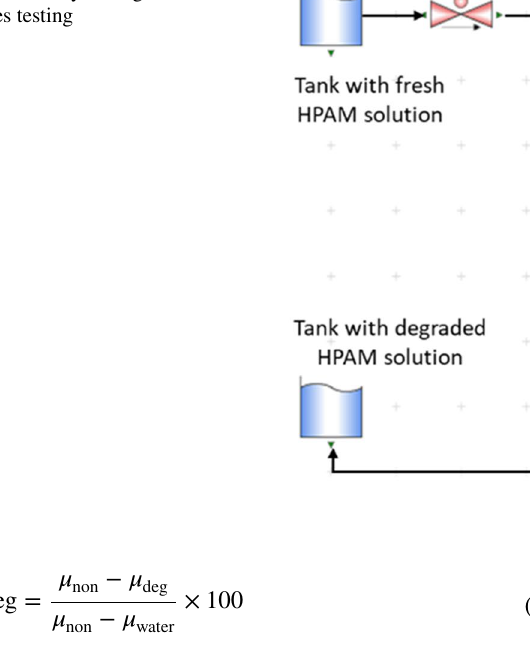
Fig. 3 Facility for regulator valves testing